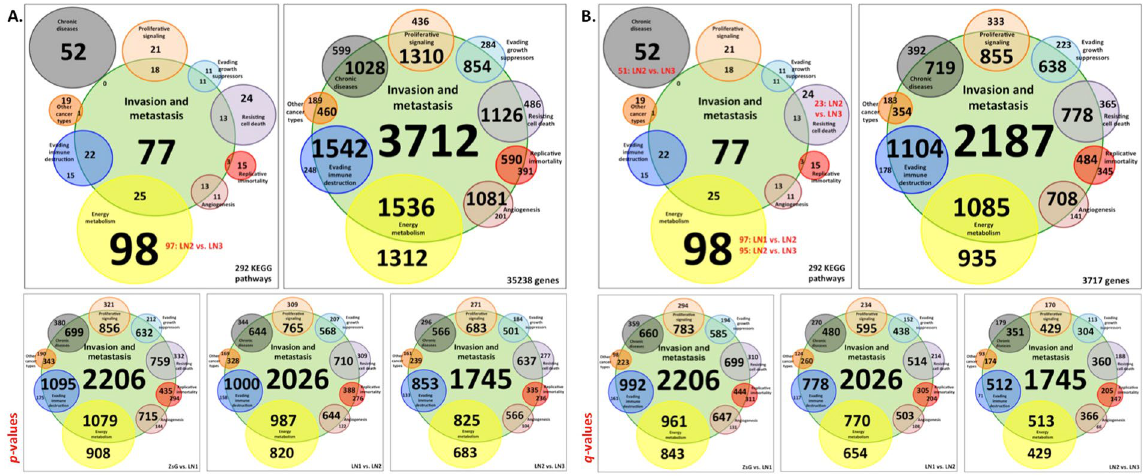
Figure 2. Contributions of each hallmark of cancer to invasion and metastasis, based on the KEGG pathways from protein coding genes. The intersections show the number of KEGG pathways (upper left panels) or genes (upper right panels). ( A ) All 292 KEGG pathways of the human genome (upper left panel) or genes related to 35238 human cDNAs annotated in Ensemble (upper right panel) and the distribution of the differentially expressed genes in all-3 comparisons of transformed cell lines (bottom panels, ZsG vs . LN1 left, LN1 vs . LN2 middle and LN2 vs . LN3 right), for p- values; ( B ) all 292 KEGG pathways of the human genome (upper left panel) or related to 3717 differentially expressed genes after FDR correction found in this study (upper right panel) and the distribution of the differentially expressed genes in all 3 comparisons of transformed cell lines (bottom panels, ZsG vs . LN1 left, LN1 vs . LN2 middle and LN2 vs . LN3 right) for q- values. In upper left panels were highlighted (in red) the changes of the number of KEGG pathways found in the transformed cell lines